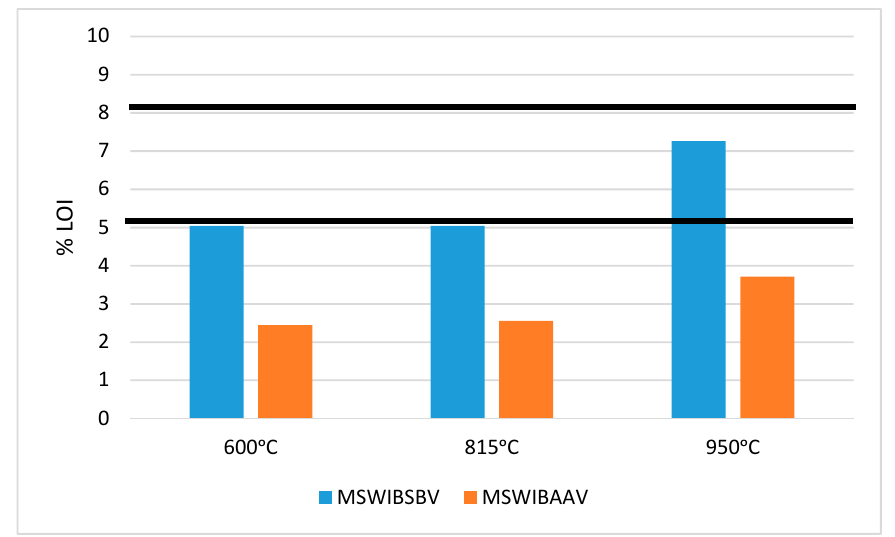
Figure 6. Loss on ignition (LOI) in 600 °C, 815 °C, and 950 °C [15].